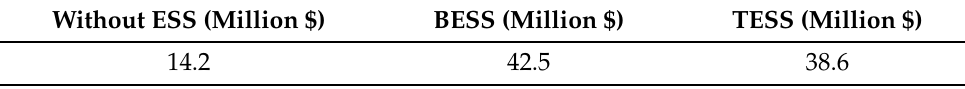
Table 6. GA results: Profit obtained for cases without and with